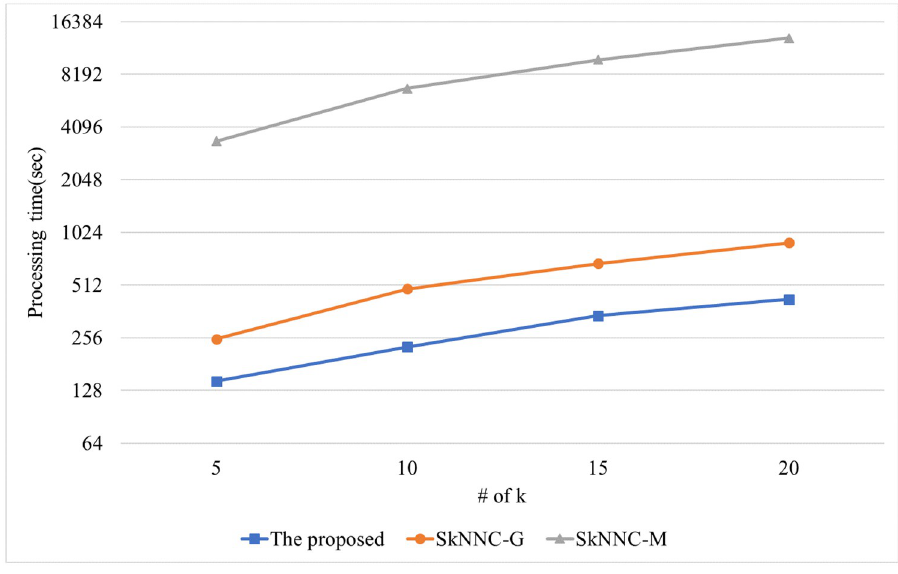
Fig 14. Processing time with varying